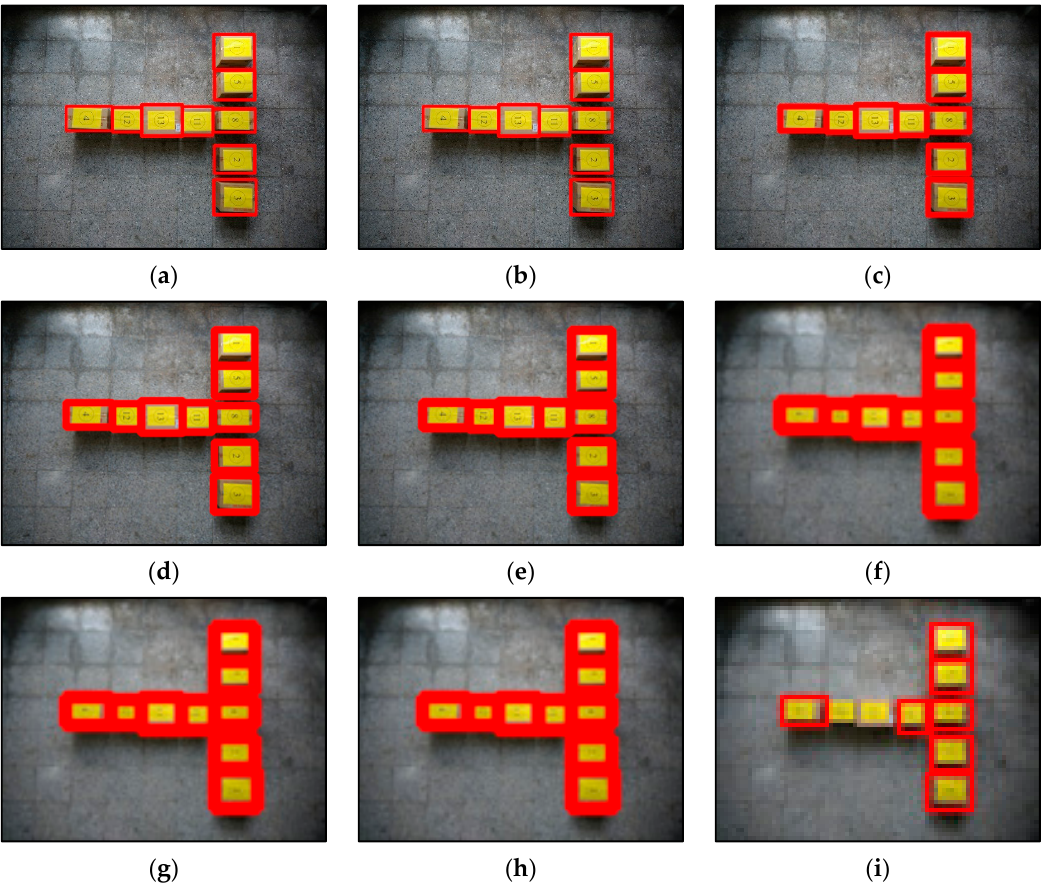
Figure 16. Object detection results: ( a ) mode1; ( b ) mode2; ( c ) mode3; ( d ) mode4; ( e ) mode5; ( f ) mode6; ( g ) mode7; ( h ) mode8; ( i ) mode9.